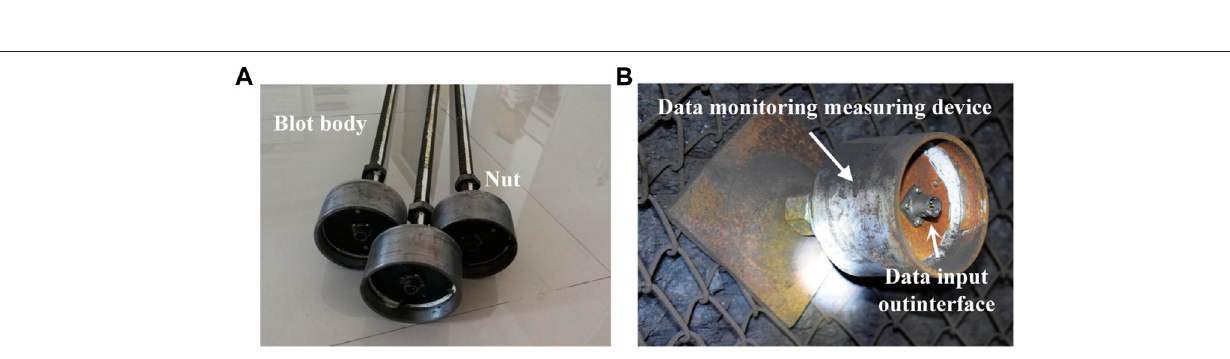
FIGURE 8 | In fl uence of mining stress: (A) variation curve of the surrounding rock strain with an advance of the driving face; and (B) the abutment pressure curve.